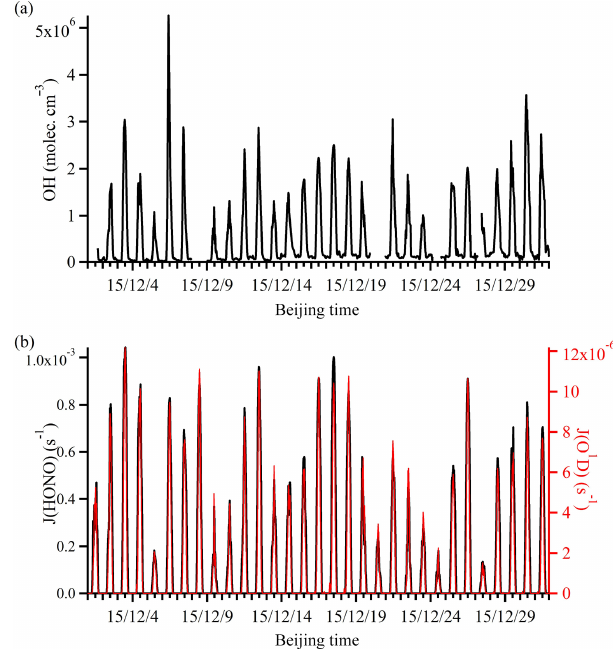
Figure 4. Time series of (a) simulated OH and (b) observed photol- ysis rates ( J( HONO ) and J( O 1 D ) ). The gaps in the OH time series were the time periods when some observational data were not avail-